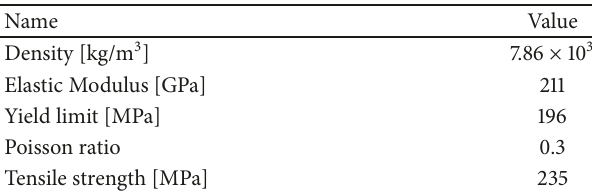
Table 6: Material properties of beam.